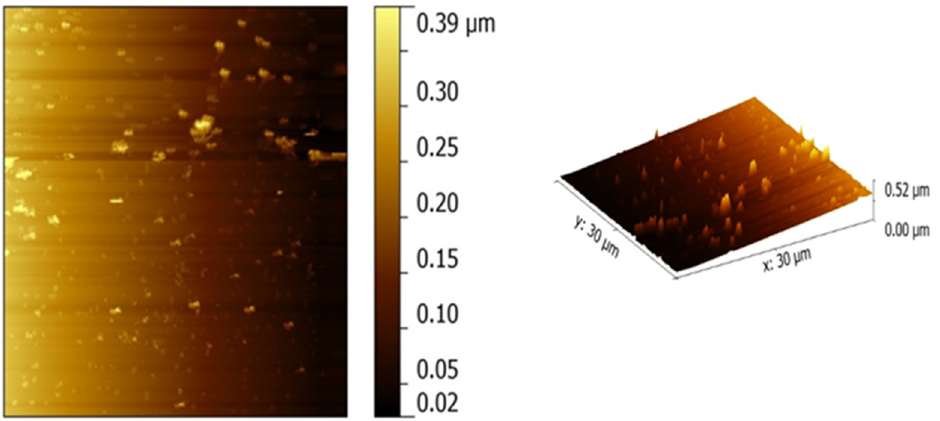
Figure 6. AFM structure of Fucoidan from Sargassum ilicifolium .